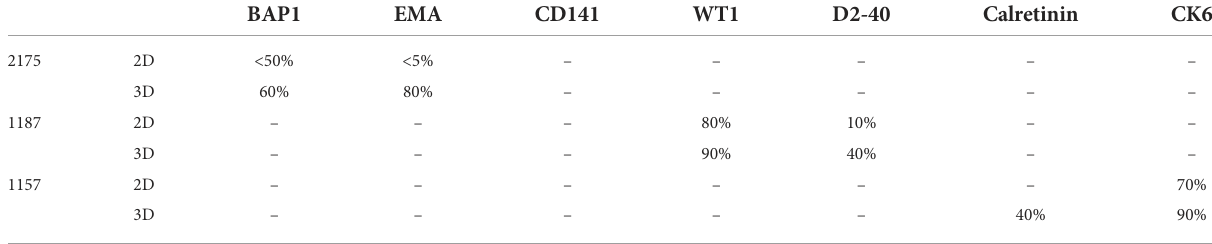
TABLE 1 Clinical used mesothelioma biomarker IHC